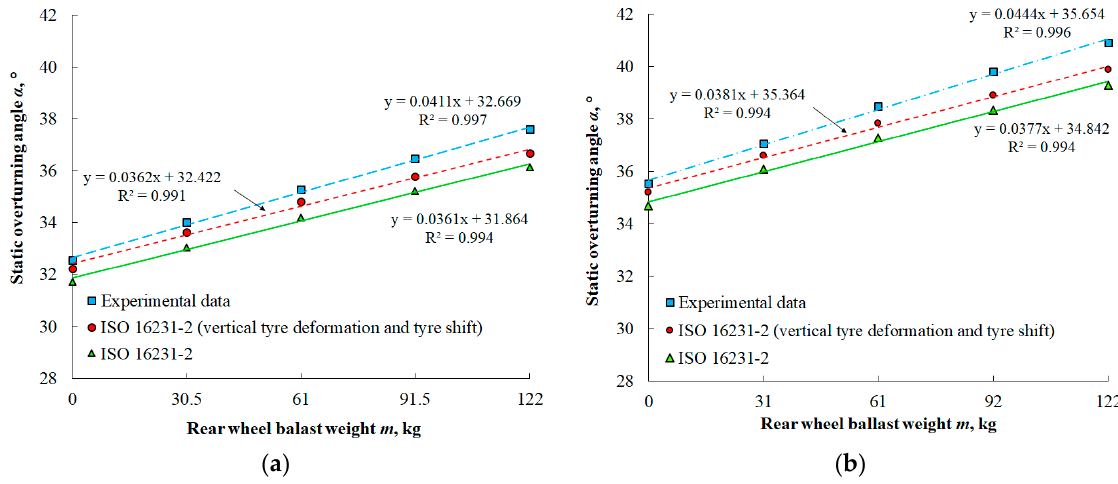
Table 6. Calculated data considering vertical tyre deformation and tyre shift.